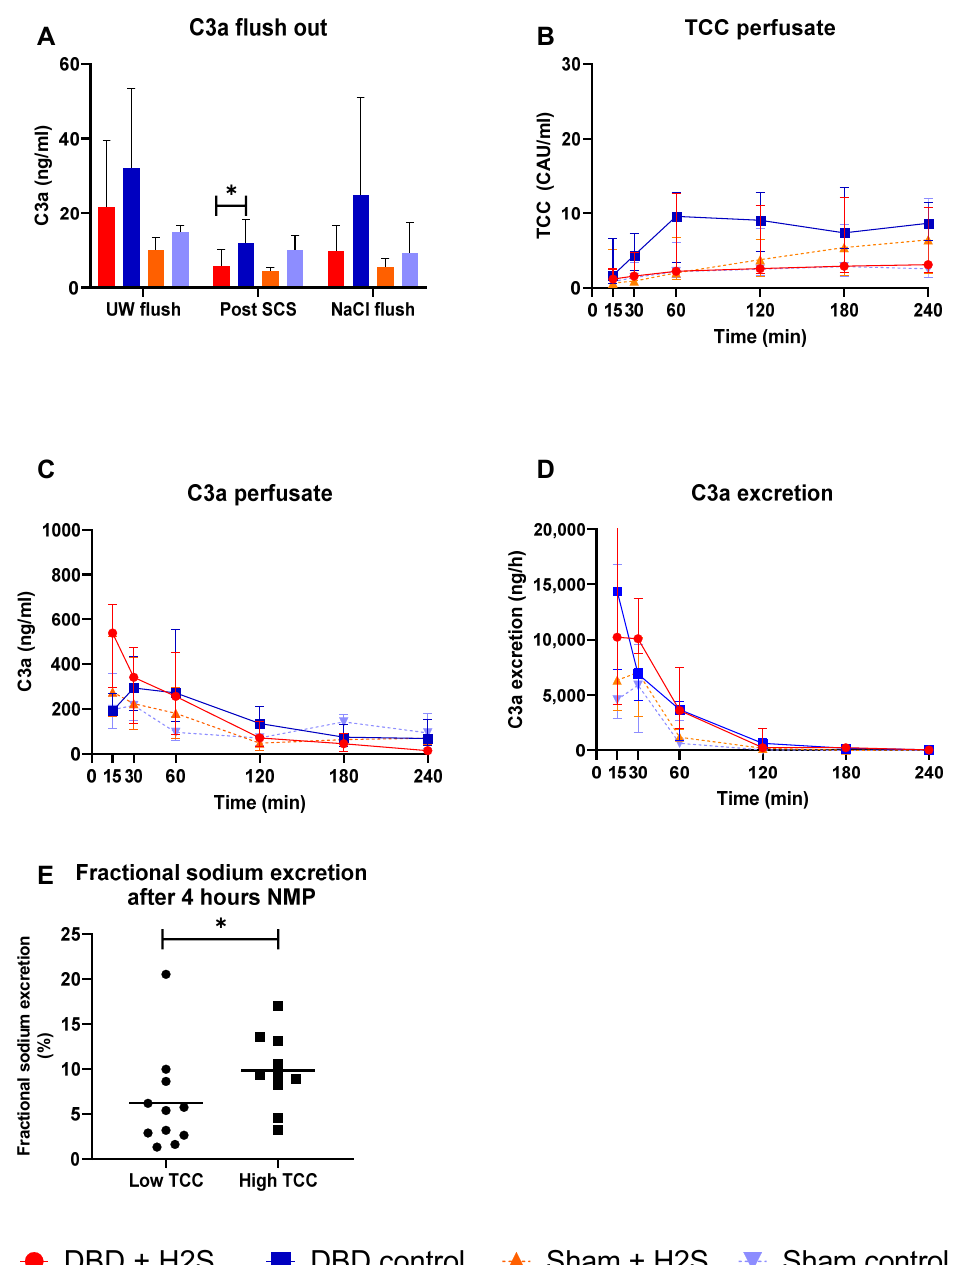
Figure 3. Complement activation. ( A ): C3a levels after the flushes and after SCS (ng/mL). ( B ): TCC in the perfusate during NMP (CAU/mL). ( C ): C3a in the perfusate during NMP (ng/mL). ( D ): C3a excretion in the urine (ng/h). ( E ): Fractional sodium excretion after 4 h NMP in the lowest TCC kidneys and the highest TCC kidneys. Data presented as median + interquartile range. * p < 0.05. Abbreviations: TCC = terminal complement complex. NMP = normothermic machine perfusion. SCS = Static cold storage.